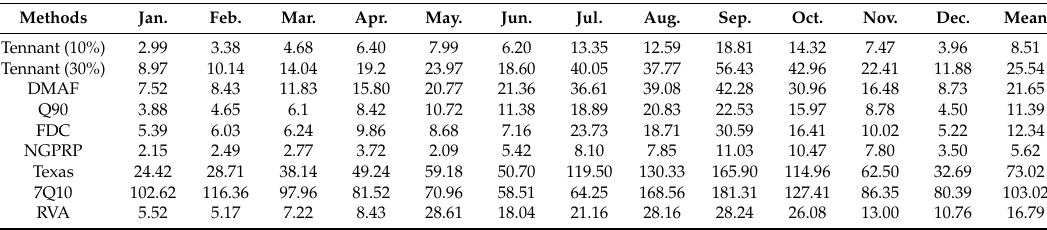
Table 3. The results of recommended EBF estimated by hydrological methods at Linjiacun station, cited from [21,47]. Owing to the space limitation, the results estimated by hydrological methods at Weijiabu, Xianyang, Lintong and Huaxian station are not mentioned here. DMAF: driest monthly average flow method, Q90: average flow method in the driest month with 90% frequency, NGPRP: northern great plains resource program. The unit is m 3 /s.